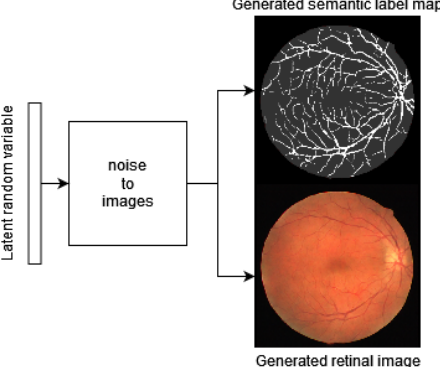
Figure 2. The single-stage image generation